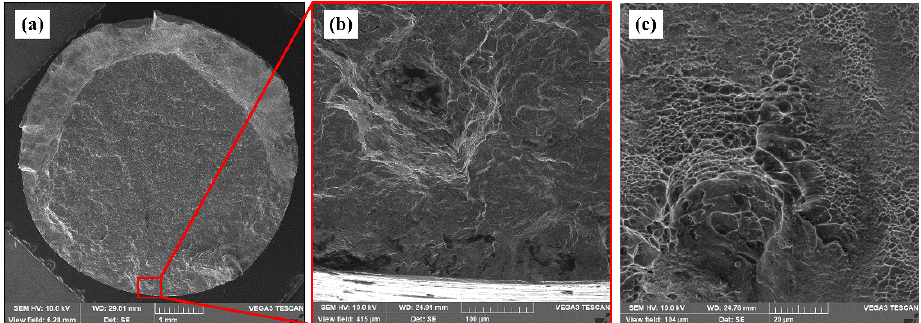
Figure 15. Scanning electron microscopy (SEM) micrographs of low cycle fatigue (LCF) fracture surface for as-built selective laser melting (SLM) Ti – 6Al – 4V tested at strain amplitude of 2.0%: ( a ) macro – fractograph, ( b ) crack initiation site, and ( c ) final rupture region.